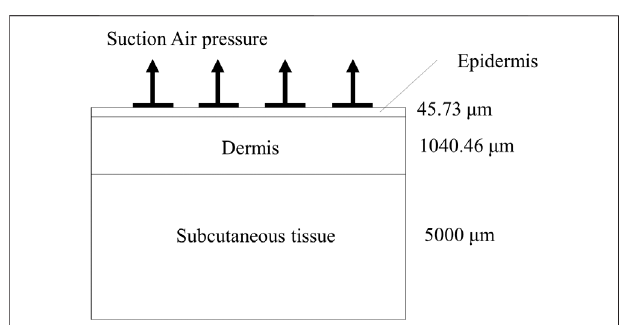
FIGURE 10 | Schematic of the skin structure model. The thicknesses of the epidermis , dermis, and subcutaneous tissue are shown. Each tissue is de fi ned as being connected to the other. Suction air pressure was applied to the epidermis in the suction direction based on the shape of the suction